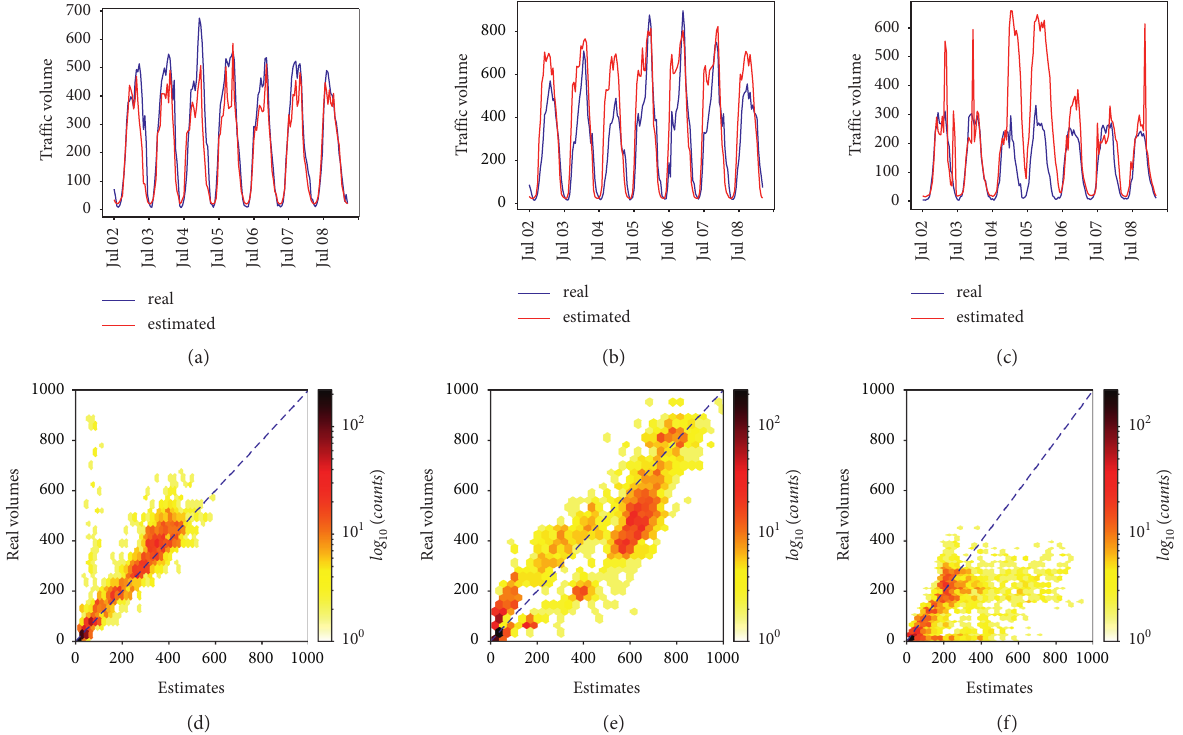
Figure 5: Examples of time series and hexabin plots for different EMFR values. (a) EMFR � 5%, (b) EMFR � 10%, (c) EMFR � 25%, (d) EMFR � 5%, (e) EMFR � 10%, and (f) EMFR �